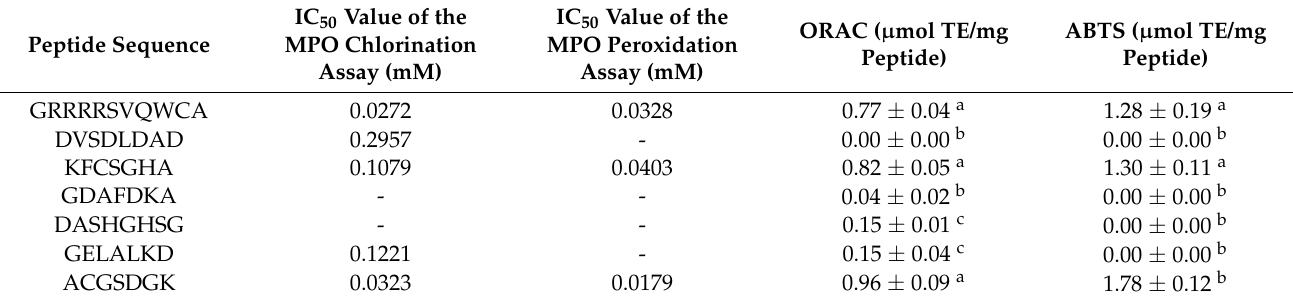
Table 2. MPO inhibition and antioxidant activity of synthesis